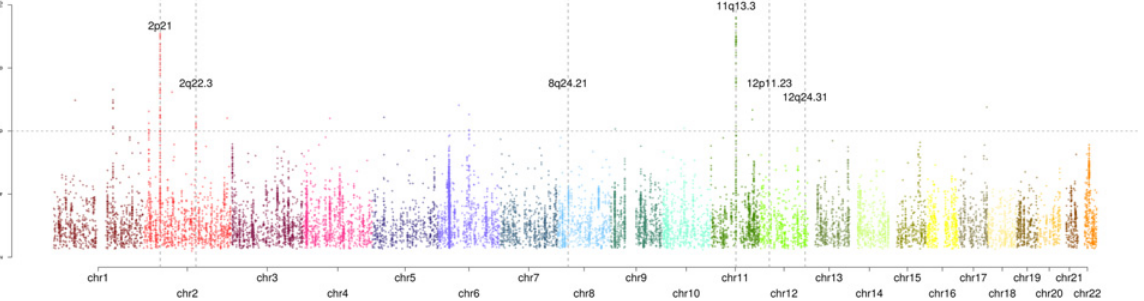
Fig 1. Genome-wide P -values ( – log 10 P , y -axis) plotted against their respective chromosomal positions ( x -axis). The horizontal line represents the significance threshold level ( P = 1.0x10 -6 ) required for variants to be taken forward to the replication stage. RCC risk loci reported in previous studies are